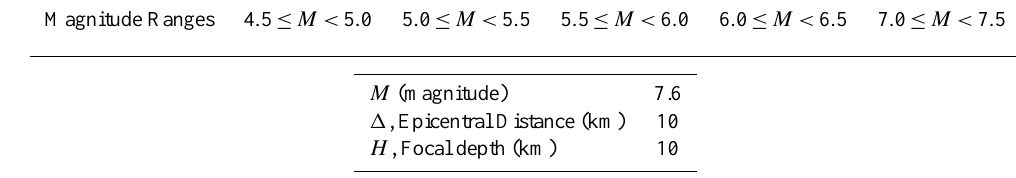
Table 2. Examples of estimated acceleration values for design magnitude, epicentral distance ( 1 , km), and focal depth ( H , km).